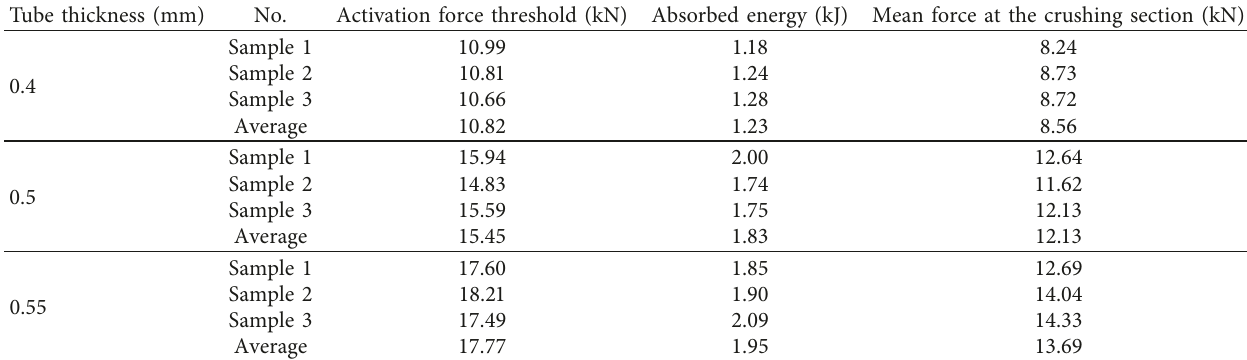
Table 3: Main mechanical parameters of the tube-crushing dissipators at static tests.